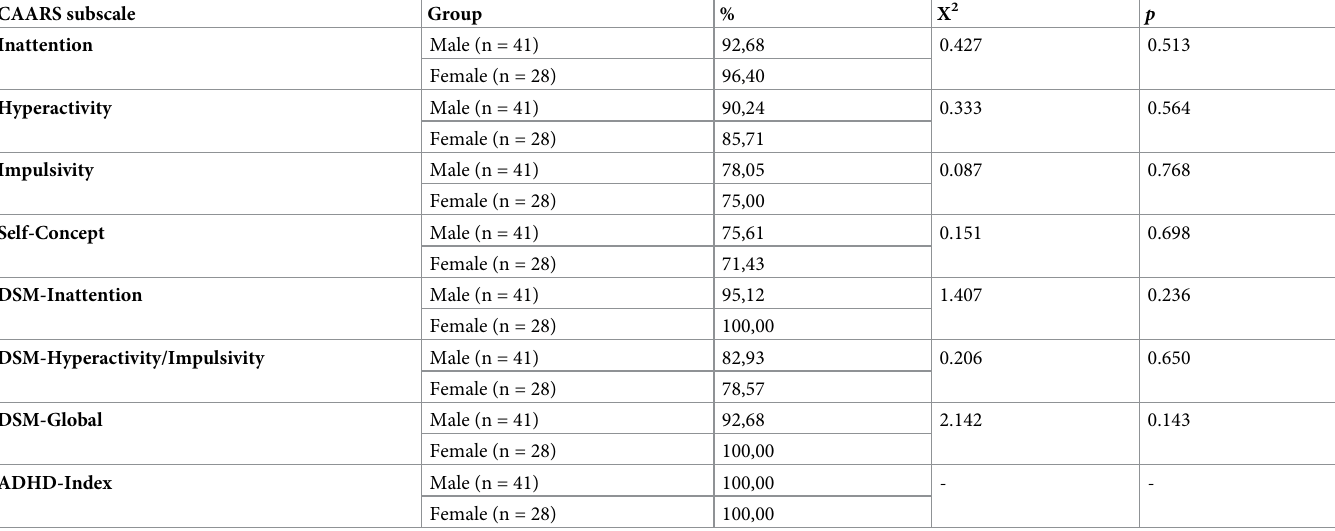
Table 2. Group differences between males and females scoring above 60 in CAARS